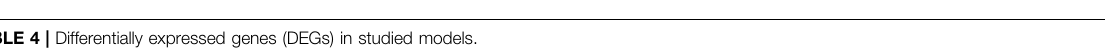
Up Down DAVID/KEGG a Up Down p < 0.05, FC > 2